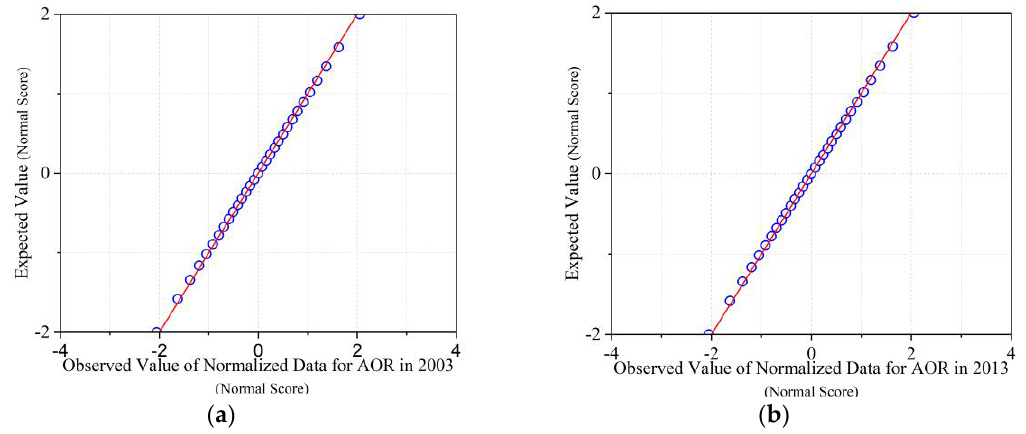
Figure 2. Normal Q-Q plots: ( a ) AOR of natural wetlands in 2003 after normal score transformation; ( b ) AOR of natural wetlands in 2013 after normal score transformation.